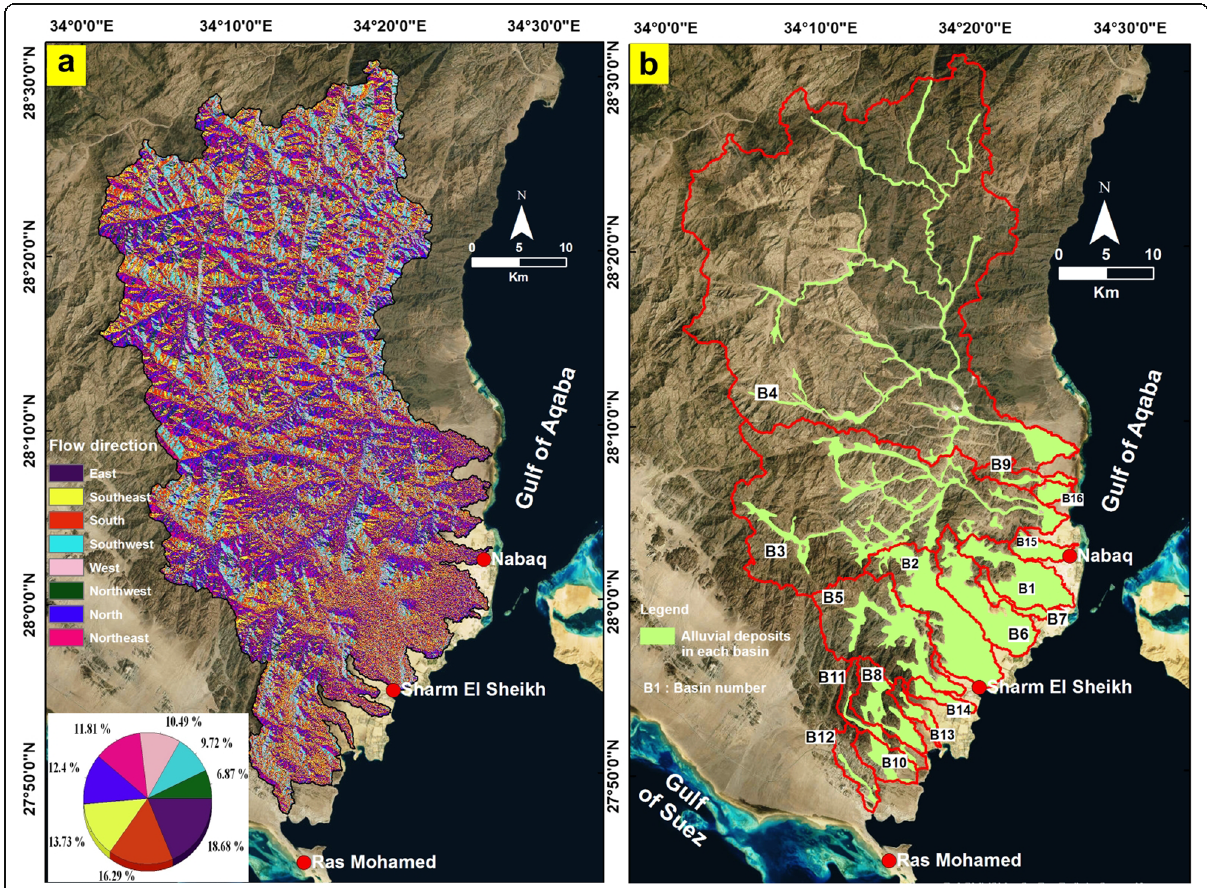
Fig. 10 a Flow direction layer showing the surface runoff with East trend (18.68%) followed by two South (16.73%) and Southeast directions (13.73%) where all surface runoff is draining to the city of Sharm El Sheikh and its vicinities. b Map of the alluvial sediments (fans and wadi deposits) that are covering parts of the studied basins where the alluvial areas ranging between 3 and 73 km